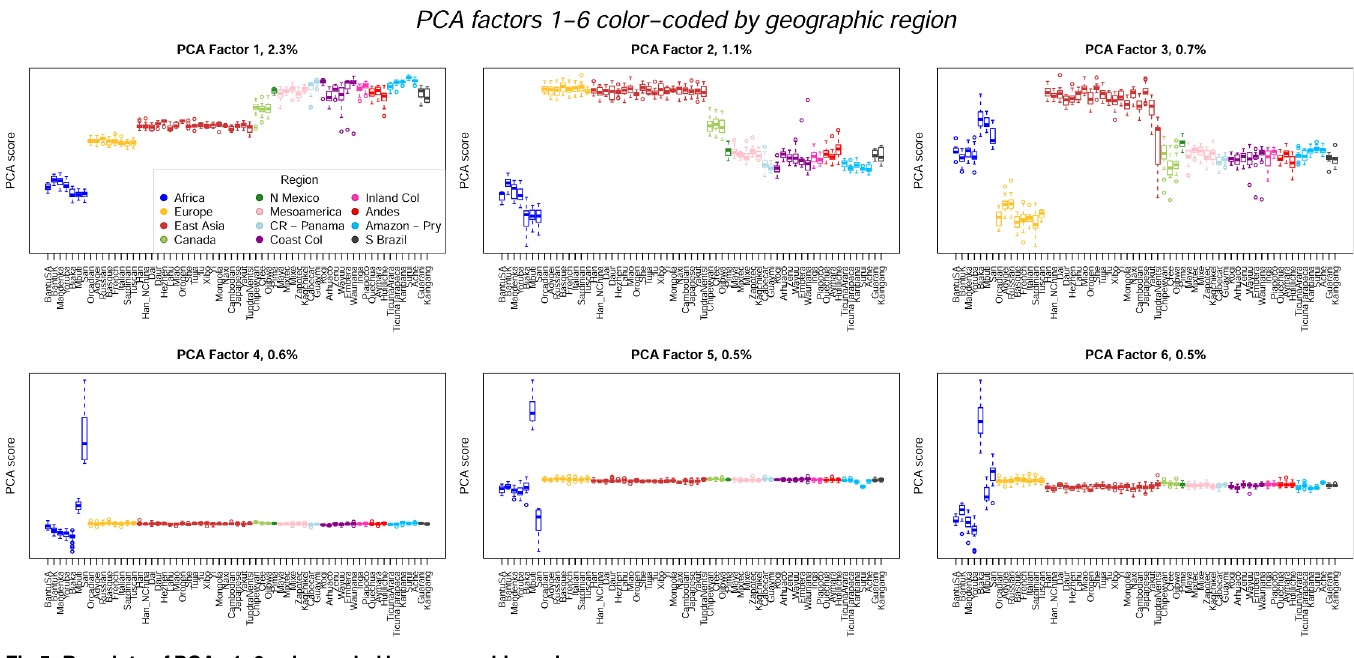
Fig 5. Boxplots of PCAs 1 – 6 color-coded by geographic region.